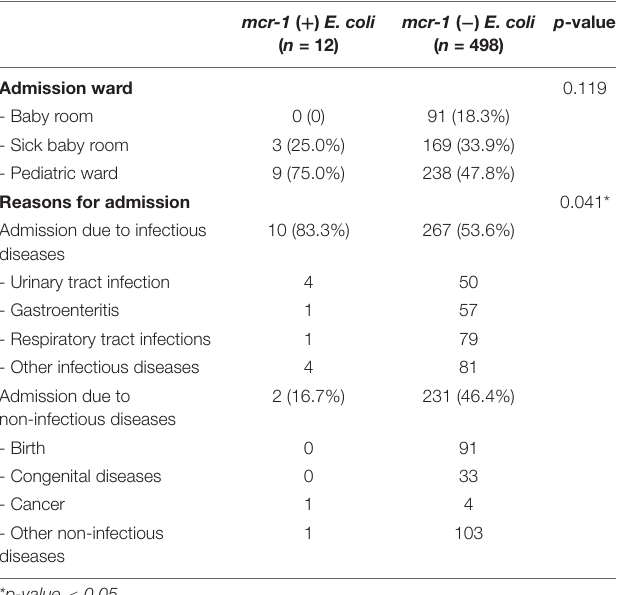
TABLE 2 | The distribution of reasons for admitting participants with and without mcr-1 -positive E. coli in their fecal carriages. mcr-1 ( + ) E. coli ( n = 12)